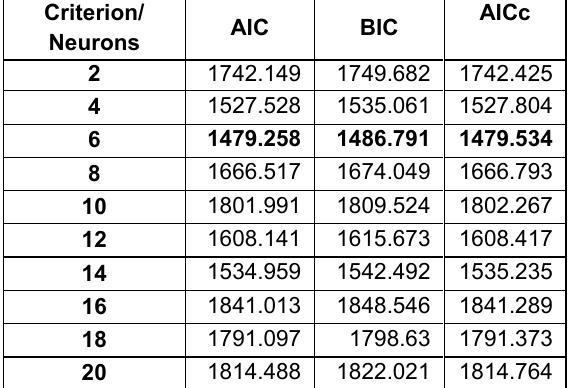
Table.3 Results of AIC, BIC, and AICc Metrics for CU